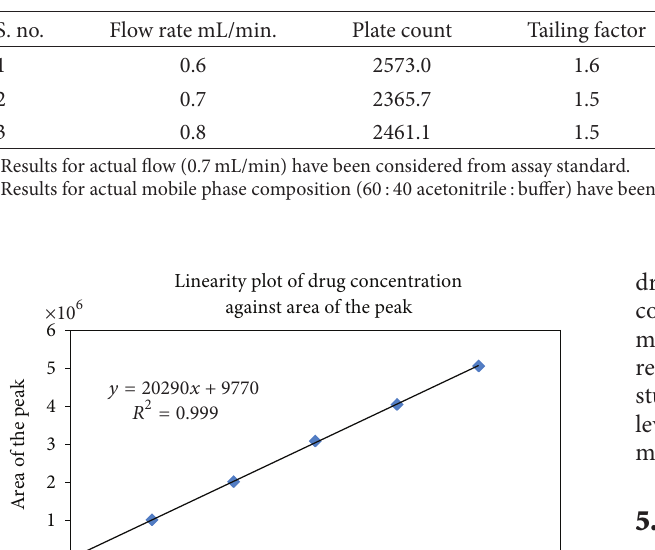
T 4: Study of robustness of the proposed method.